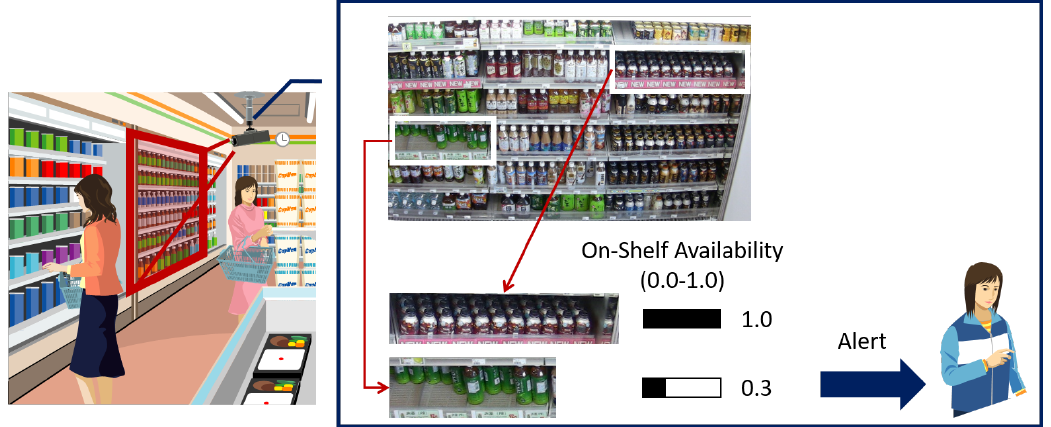
Figure 1. Overview of our target application to monitor the shelves in retail stores using a surveillance camera for maintaining high on-shelf